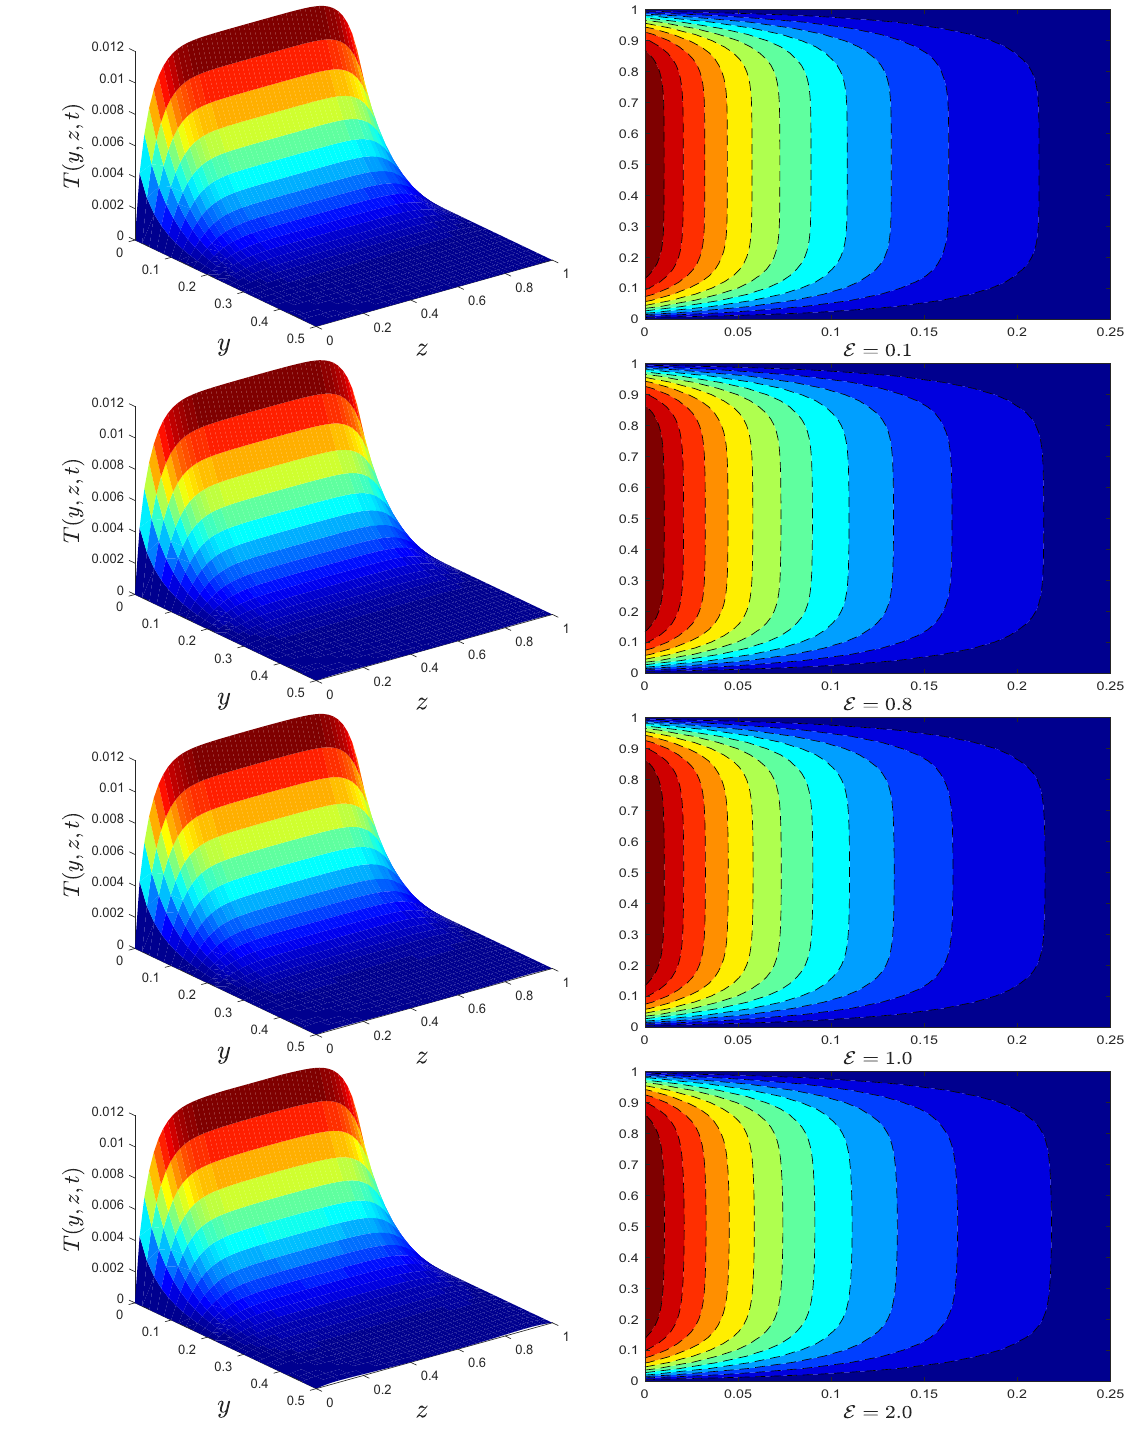
Figure 5. Temperature profile for different values of dissipation parameter E